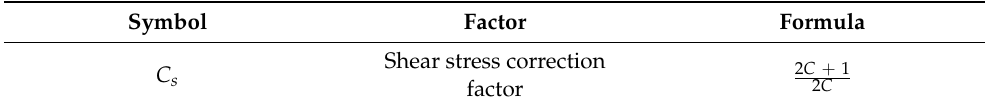
Table 2. Factor used for spring design